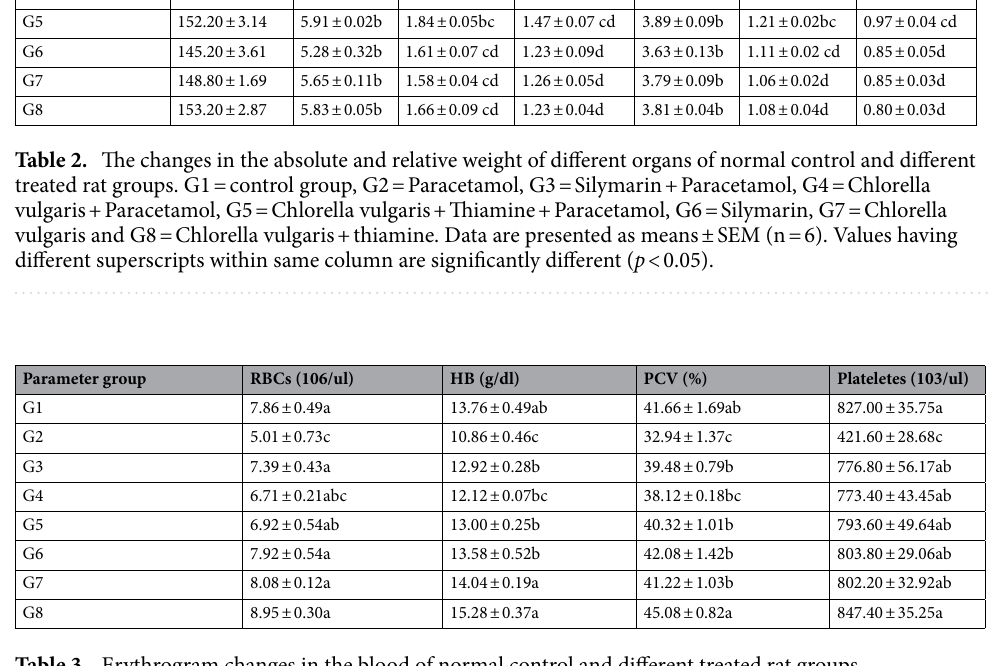
Table 3. Erythrogram changes in the blood of normal control and different treated rat groups. G1 = control group, G2 = Paracetamol, G3 = Silymarin + Paracetamol, G4 = Chlorella vulgaris + Paracetamol, G5 = Chlorella vulgaris + Thiamine + Paracetamol, G6 = Silymarin, G7 = Chlorella vulgaris and G8 = Chlorella vulgaris + thiamine. RBCs = Red blood cells, HB = Hemoglobin, PCV = Packed cell volume. Data are presented as means ± SEM (n = 6). Values having different superscripts within same column are significantly different ( p < 0.05).